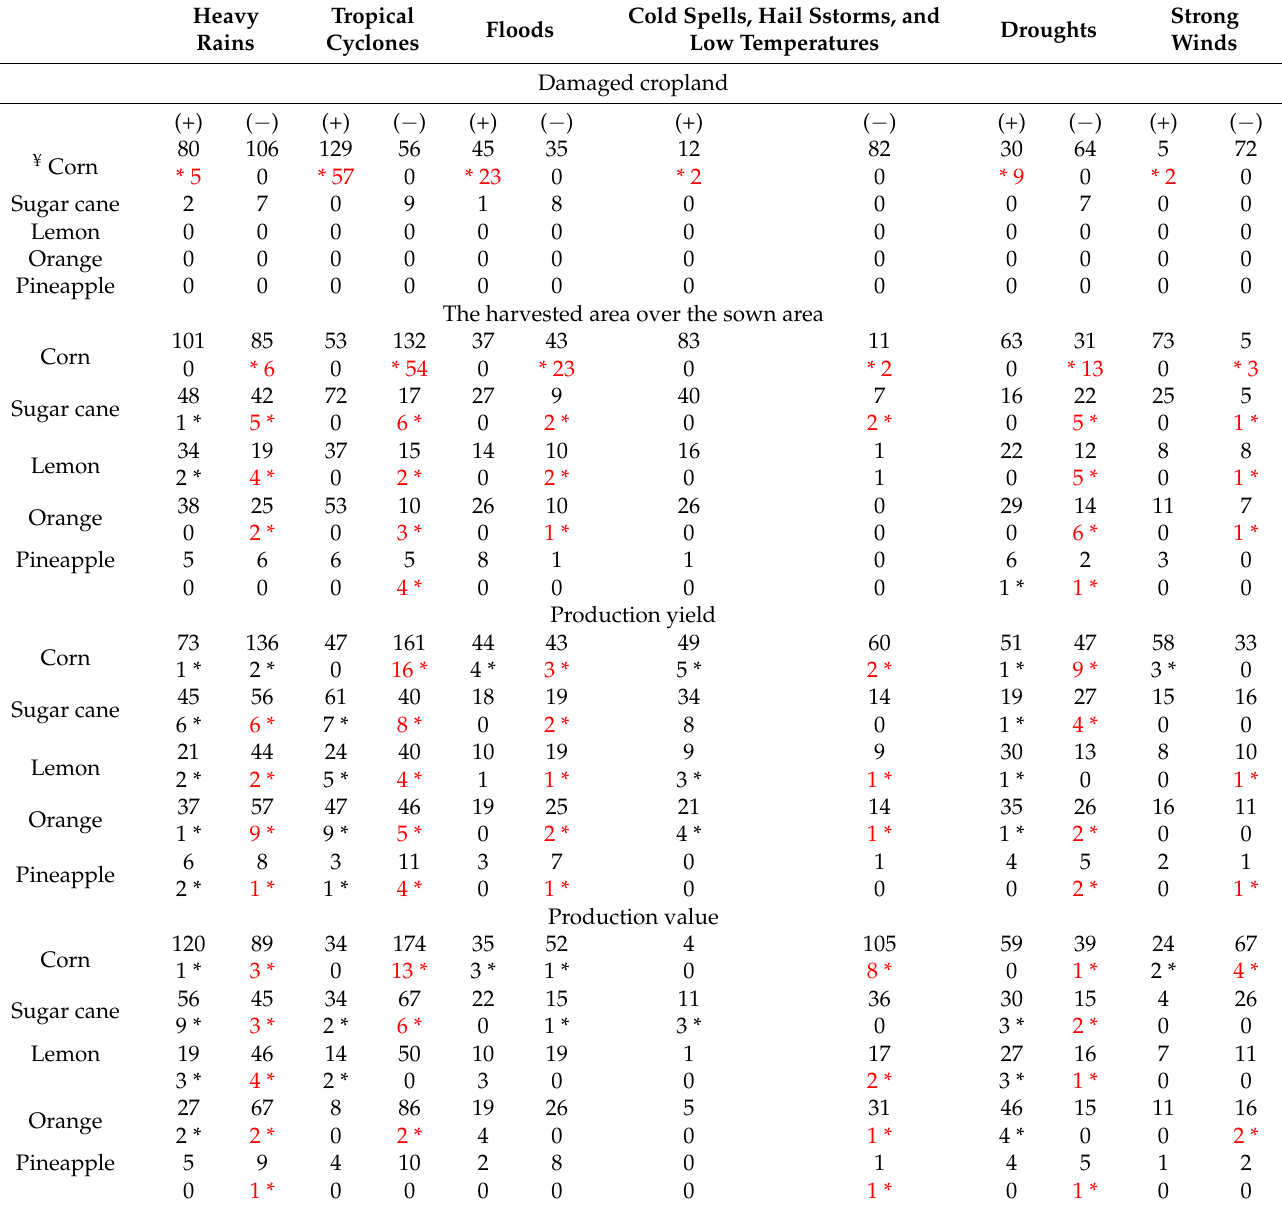
Table 3. Number of municipalities cultivating the five most valuable crops affected by hydrometeoro- logical hazards correlated with production values from 2003 to 2020 in the State of